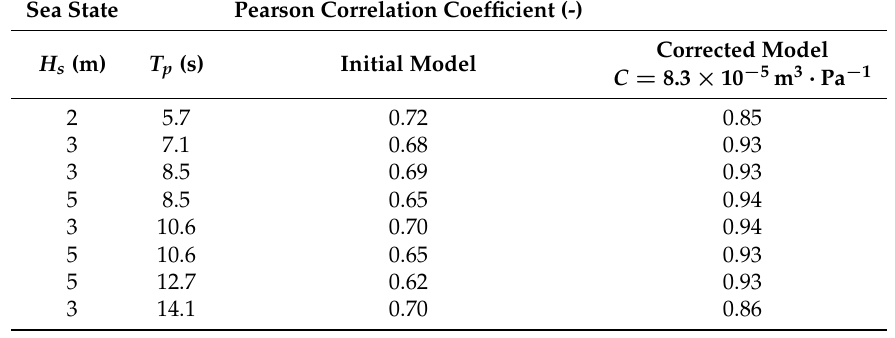
Table 3. Pearson correlation coefficient between ∆ P t time series obtained physically and numerically for the various irregular sea states.